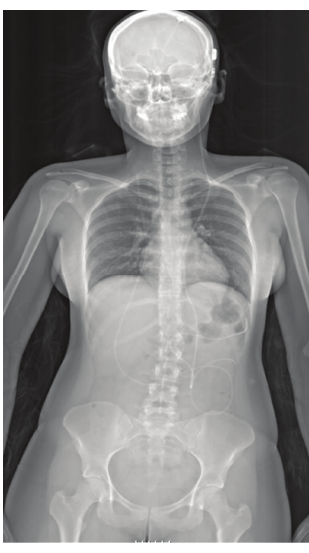
Figure 1: Lodox radiograph showing a ventriculoperitoneal